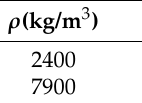
Figure 7. Loading and boundary conditions of Filigree ceiling slabs.